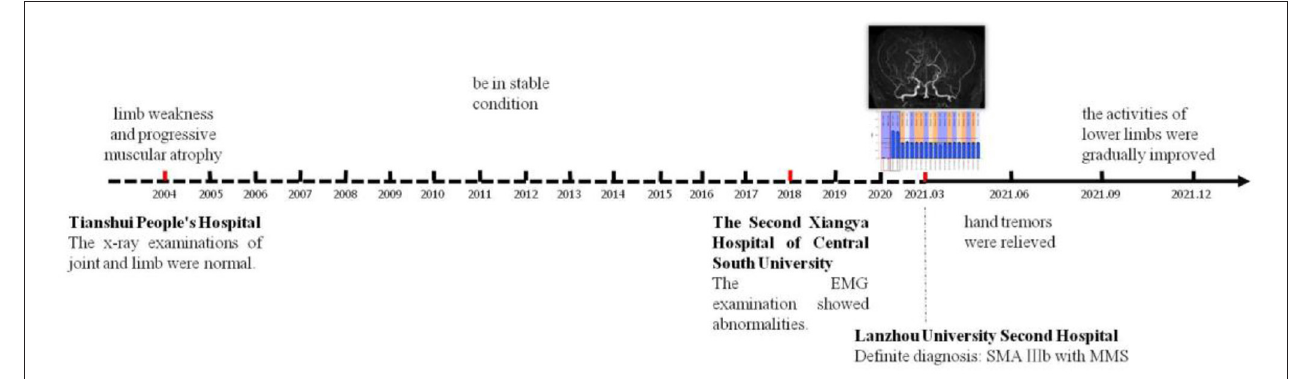
FIGURE 6 | The timeline reflects the whole process from the onset of the disease to the definite diagnosis in our hospital and regular follow-up after